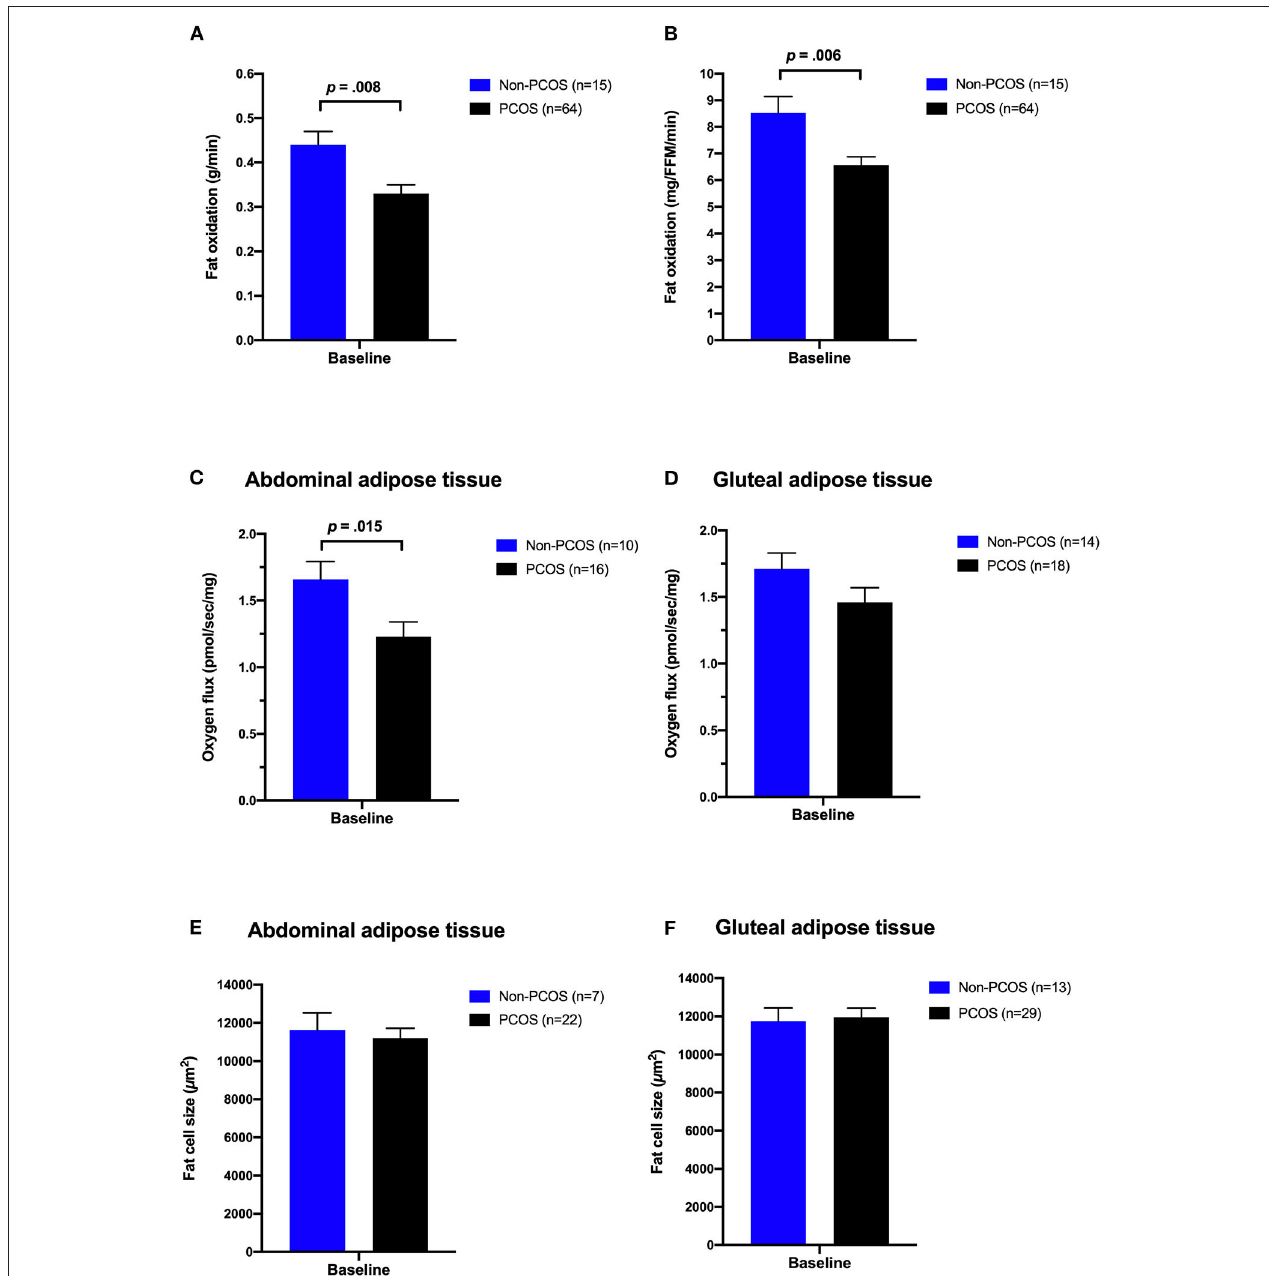
FIGURE 2 | Comparisons between women with PCOS and non-PCOS women at baseline. Whole-body fat oxidation during submaximal exercise (A,B) , oxygen flux with complex I + II linked substrates in subcutaneous abdominal (C) and gluteal adipose tissue (D) , and abdominal (E) and gluteal (F) adipose tissue cell size in non-PCOS (blue bars) and women with PCOS (black bars). The bars and error bars represent estimated means and SE based on linear mixed